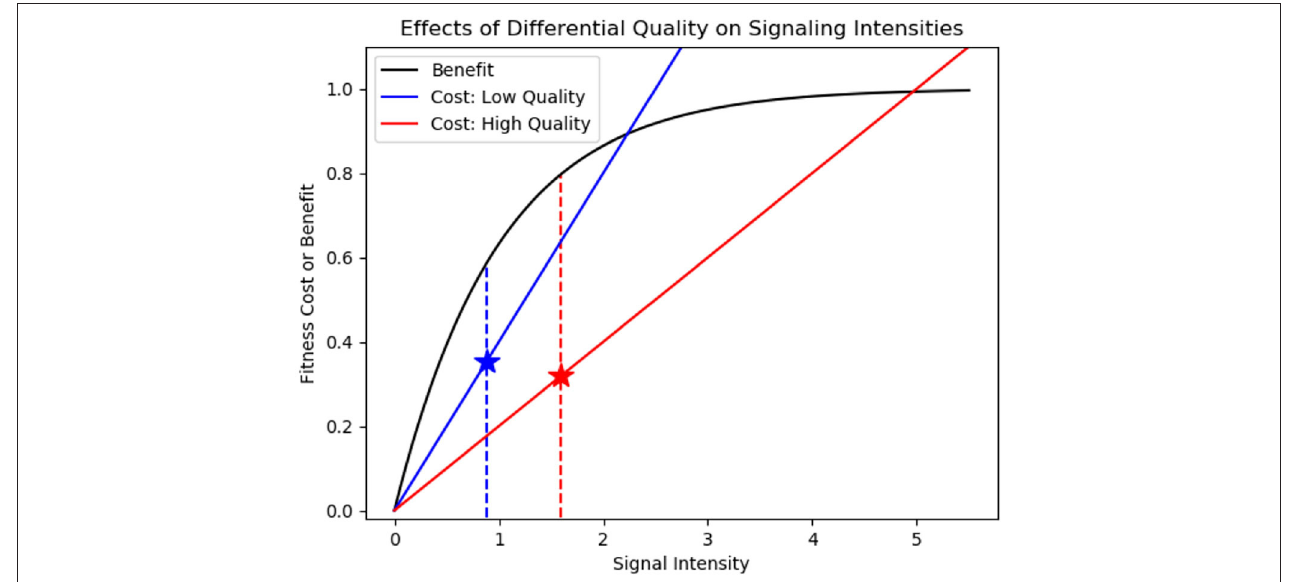
FIGURE 1 | Lower signaling costs support higher signal intensities for high quality signalers (inspired by Johnstone, 1977). The black curve represents the fitness benefit of signaling for a signaler. The blue curve represents the fitness cost of signaling for a low quality signaler: the cost of signaling increases rapidly with signal intensity. The red curve represents the fitness cost of signaling for a high quality signaler: the cost of signaling increases more gradually with signal intensity. Signalers will signal at an intensity that maximizes the difference between benefits and costs (indicated by blue and red stars). Because the cost curve is less steep for high quality signalers, the intersection point will occur at a higher signal intensity.